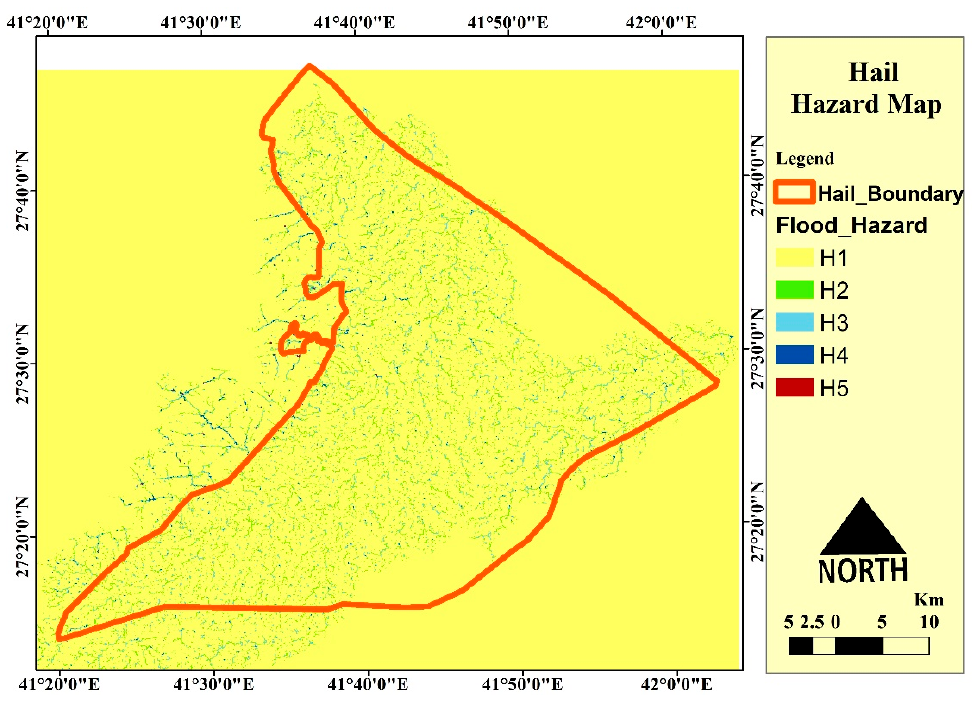
Figure 13. Hazard map of Hail city.